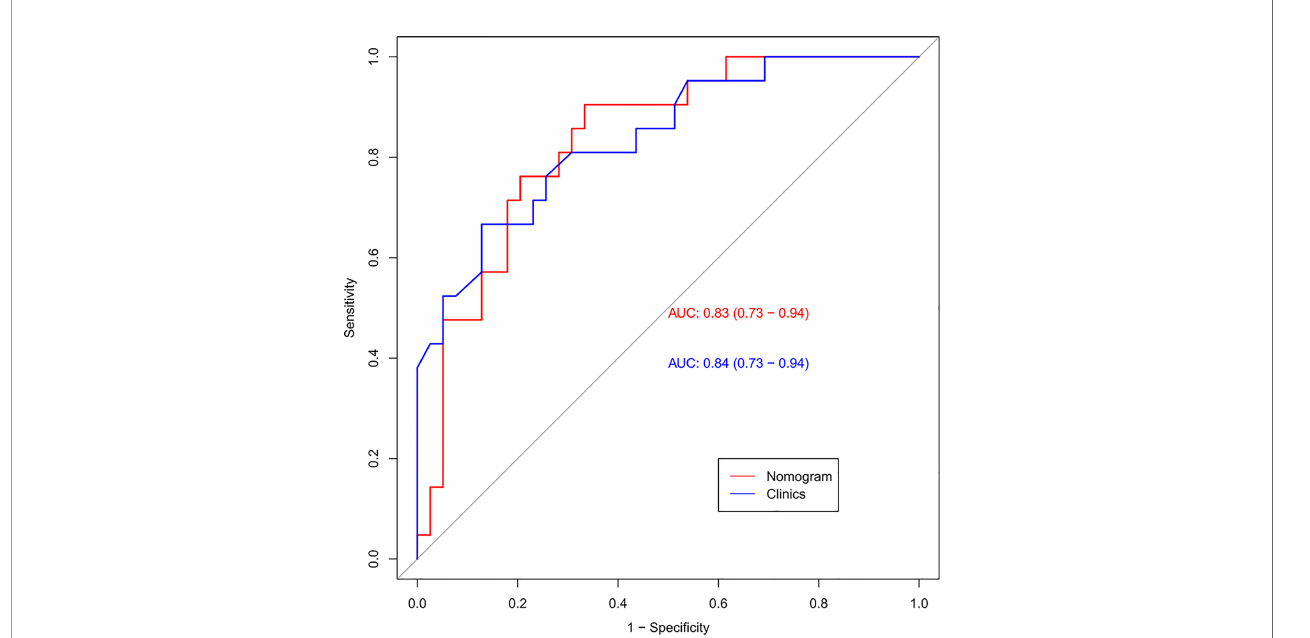
FIGURE 6 | The ROC curves (AUC) of the external testing